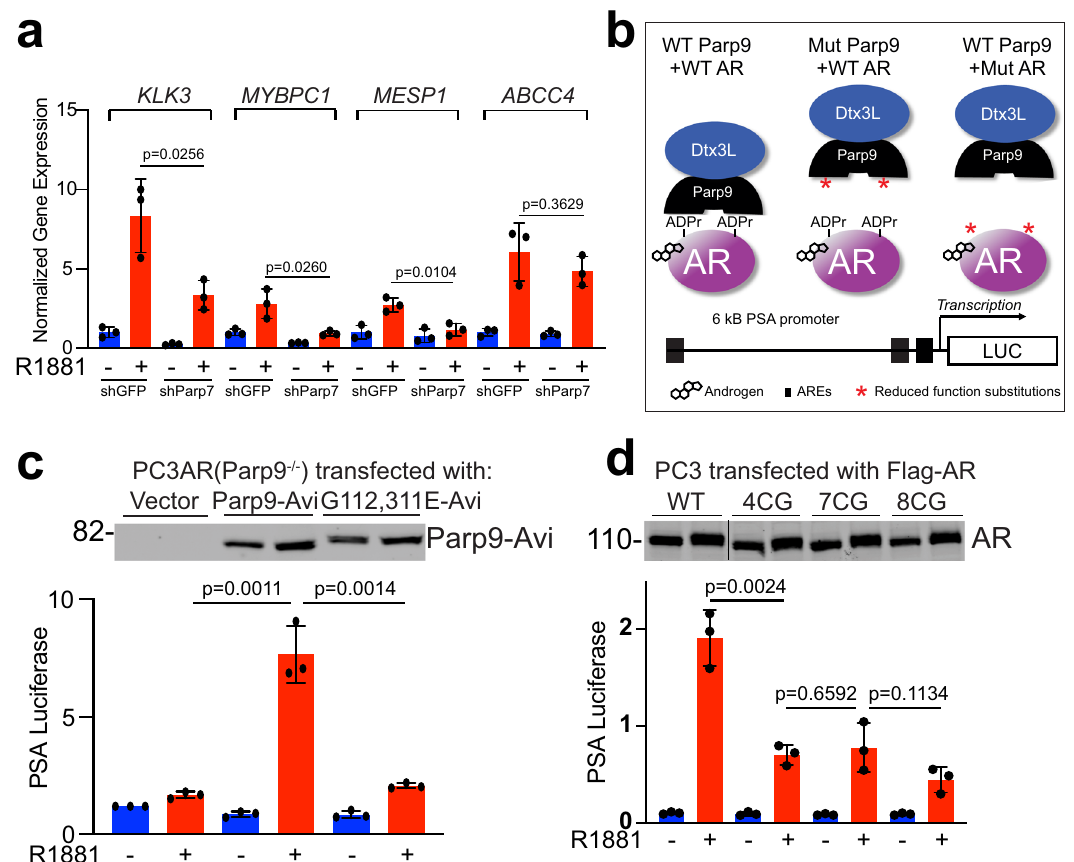
Fig. 7 ADP-ribosylation and macrodomain function contribute to AR-dependent transcription. a qPCR of AR target genes in control (shGFP) and Parp7- depleted (shParp7) VCaP cells, untreated (blue) and androgen-treated (red). The data were analyzed by an unpaired, two-tailed t test and are plotted as the mean + s.d. Dots represent individual values. For each treatment group, n = 3 biologically independent samples. b Scheme for testing the effects of Parp9 MD and AR ADP-ribosylation mutants on androgen-induced transcription from the PSA promoter. c Parp9 MD function is required for AR- dependent transcription. Parp9 knockout cells (PC3-AR background) were reconstituted with WT and mutant (G112, 311E) forms of Parp9, and AR activity measured using the 6-kB PSA promoter fused to fi re fl y luciferase. Data were normalized to CMV-Renilla luciferase and Parp9 levels examined by immunoblotting. Color scheme is the same as a . The data were analyzed by an unpaired, two-tailed t test and are plotted as the mean + s.d. Dots represent individual values. For each treatment group, n = 3 biologically independent samples. d Mutation of ADP-ribosylation sites reduces AR-dependent transcription. AR-negative PC3M-HA-Parp7 cells were reconstituted with WT and mutant (4CG, 7CG, 8CG) forms of AR, and analyzed as described in c . The data were analyzed by an unpaired, two-tailed t test and are plotted as the mean + s.d. The color scheme is the same as a . Dots represent individual values. For each treatment group, n = 3 biologically independent samples. Source data are provided as a Source data fi